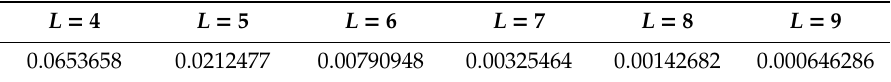
Table 12. Retardation corrections (MHz) for lithium for N = 10.